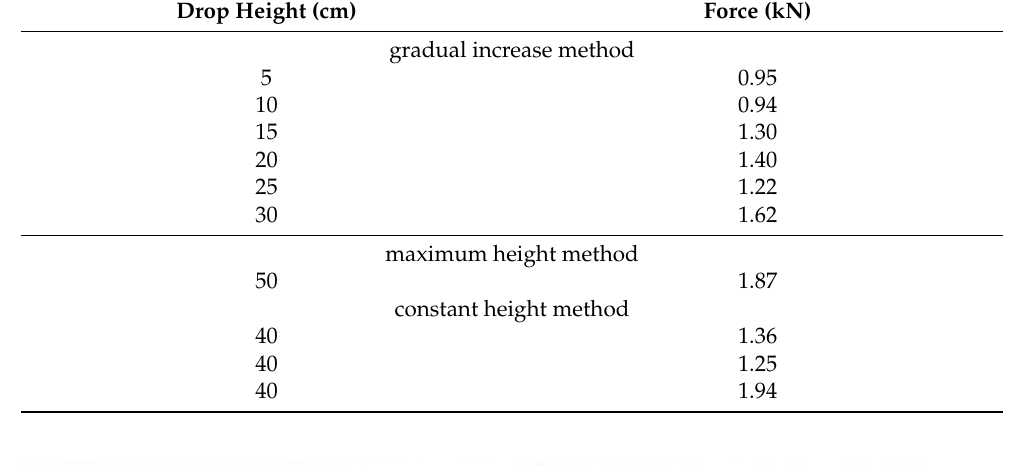
Table 4. Data from plasterboard reinforced with 1 mm thick sheet metal testing.